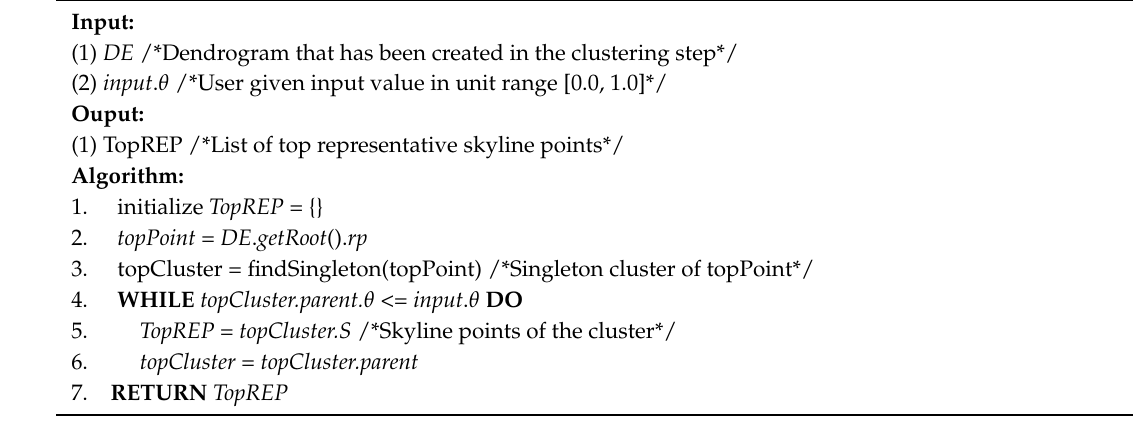
Algorithm 4. Top Representative